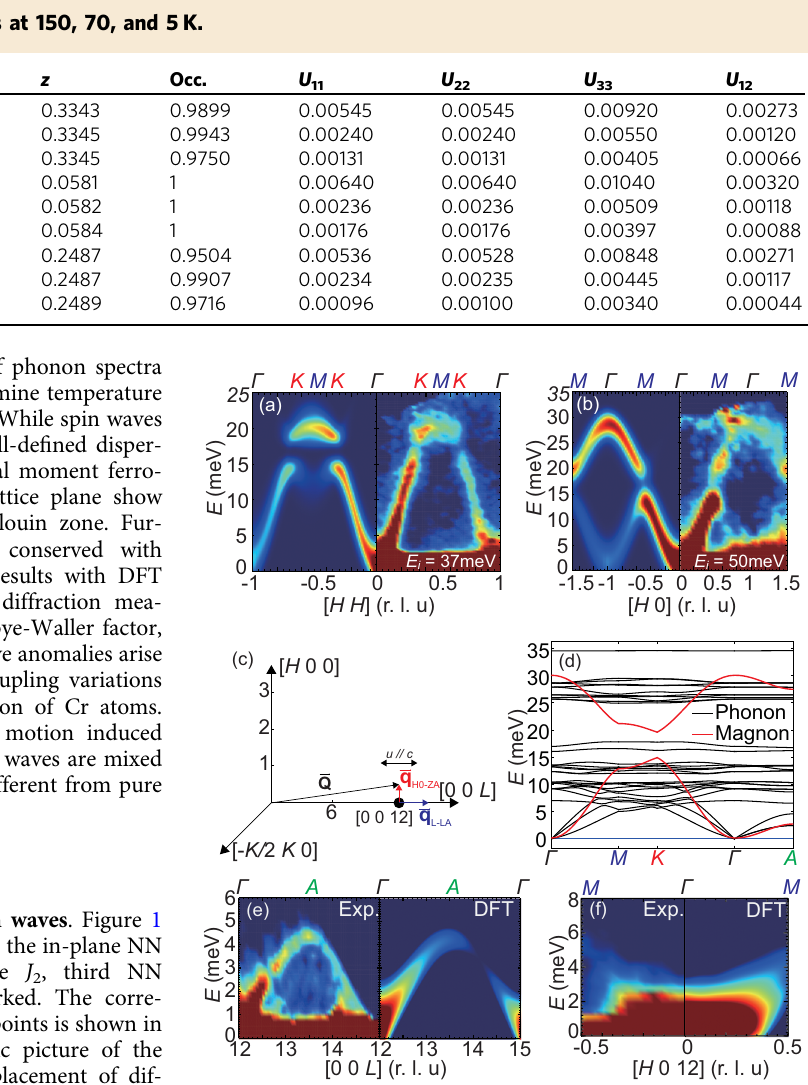
Fig. 2 Magnon and phonon spectra of CrGeTe 3 . a , b INS spectra in the [ H , H ] and [ H , 0] directions, respectively. c Experimental geometry for phonon modes probed in the experiment. d The calculated bulk phonon spectrum and fi tted magnon spectrum. e The experimental (left) and DFT calculated (right) spectrum of L ( c ) direction longitudinal acoustic (L-LA) phonon, respectively; f The experimental (left) and calculated (right) spectrum of in-plane direction transverse acoustic phonon,